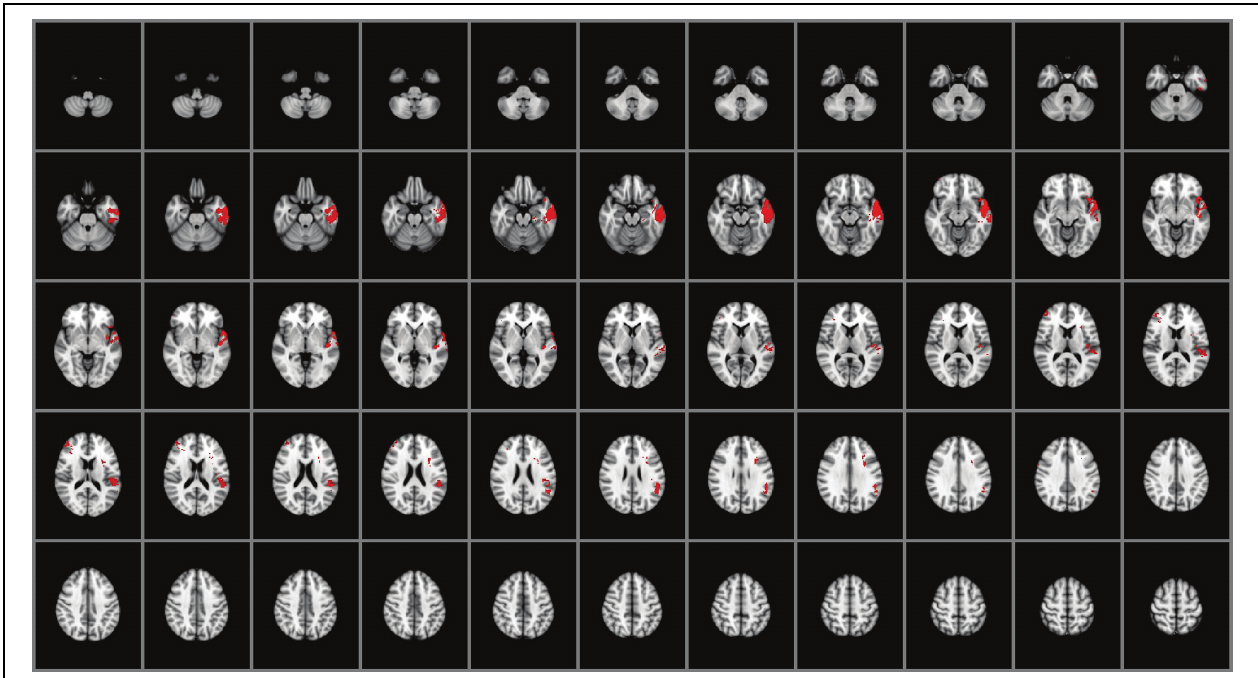
FIGURE 1 | Voxel-based lesion-symptom mapping (VLSM) of perceiving emotions ( n = 130). The statistical brain map of VLSM results in Montreal Neurological Institute (MNI) space is thresholded at q < 0.05 (using a false discovery rate correction for multiple comparisons). In each axial slice, the right hemisphere is on the reader’s left.